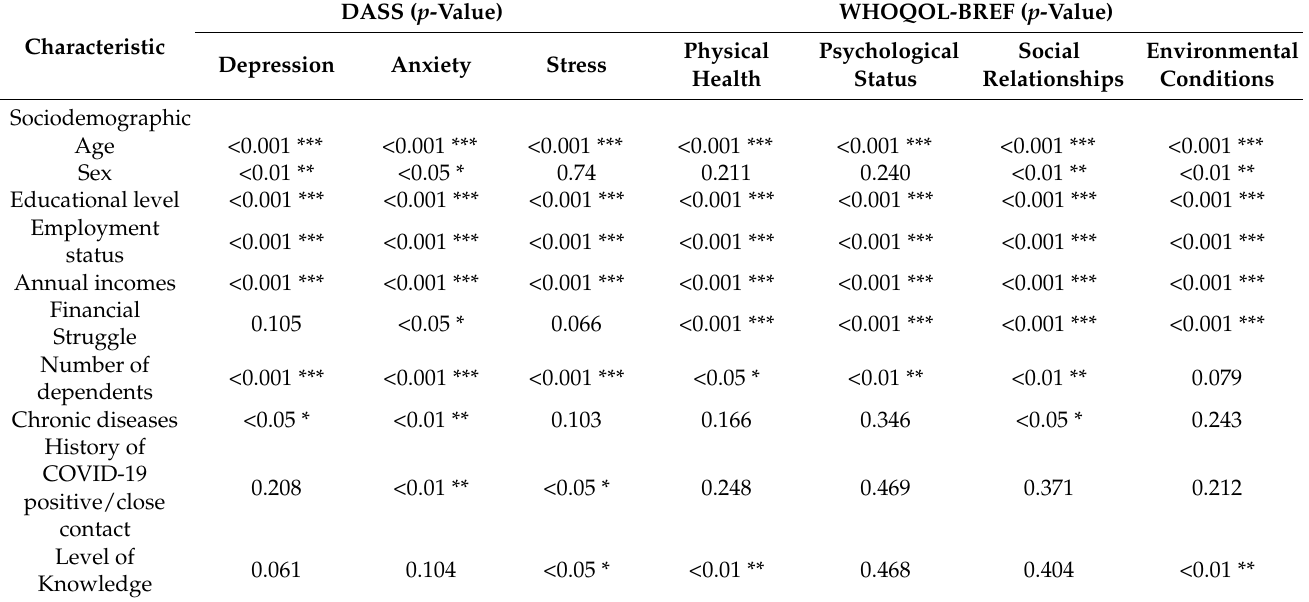
Table 3. ANOVA Analysis of the Association of Depression, Anxiety, and Stress Scale (DASS) and Quality of Life (WHOQOL-BREF) with Sociodemographic and Level of Knowledge among